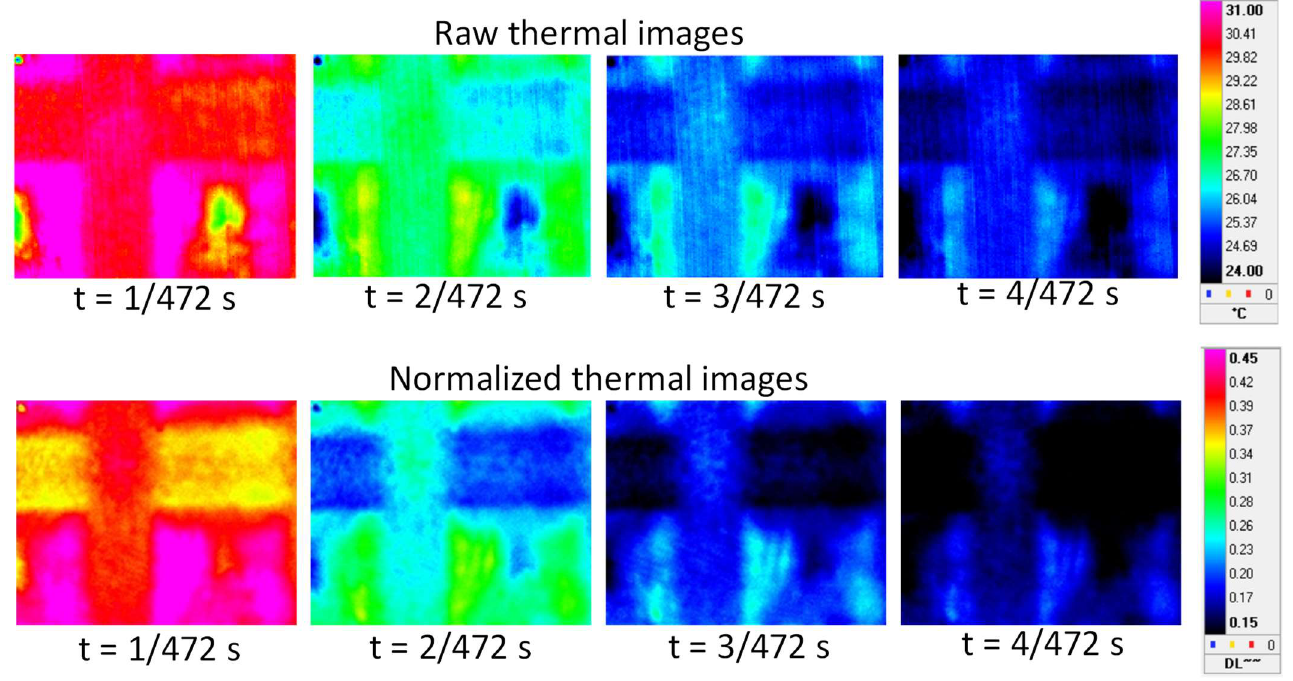
Figure 3. Raw and normalized thermal images of the ROI at different time frames after the flash.